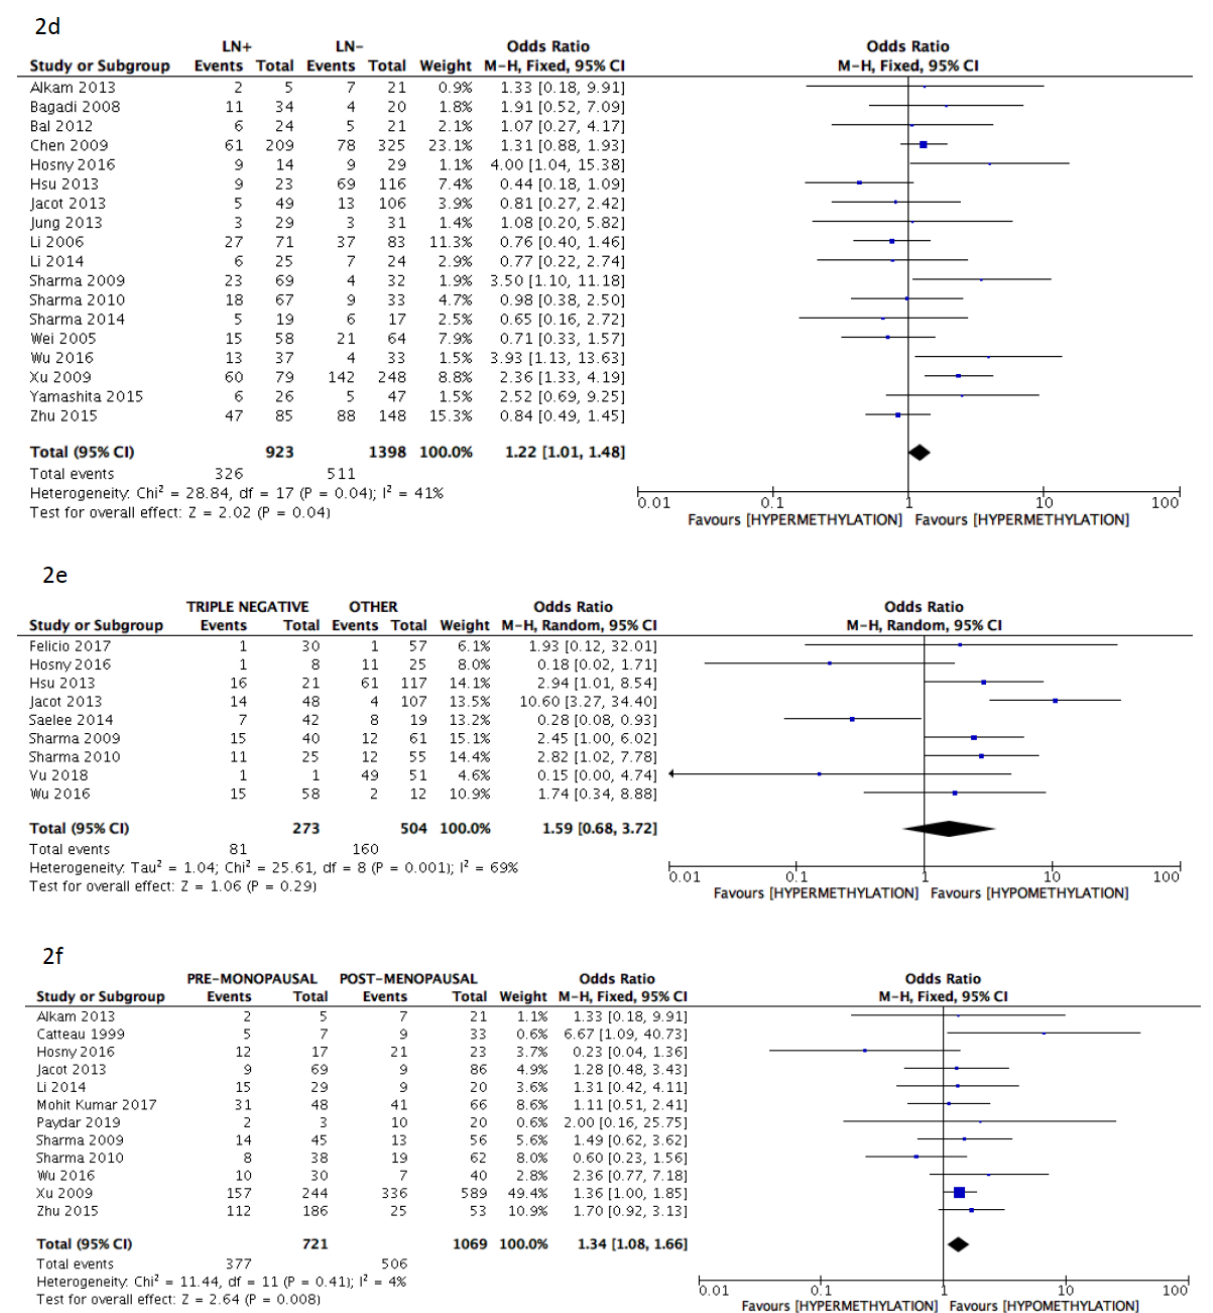
Figure 2. Pooled results on forest plots about the correlation between breast cancer gene 1 (BRCA1) gene methylation status with breast cancer patients’ clinicopathological characteristics. Events= number of BRCA1 gene hypermethylated cases. Figure shows the correlation between BRCA1 gene methylation and histology (2 a ), disease stage (2 b ), tumor grading (2 c ), lymph nodal status (2 d ), molecular classification (2 e ) and menopausal status (2 f ).